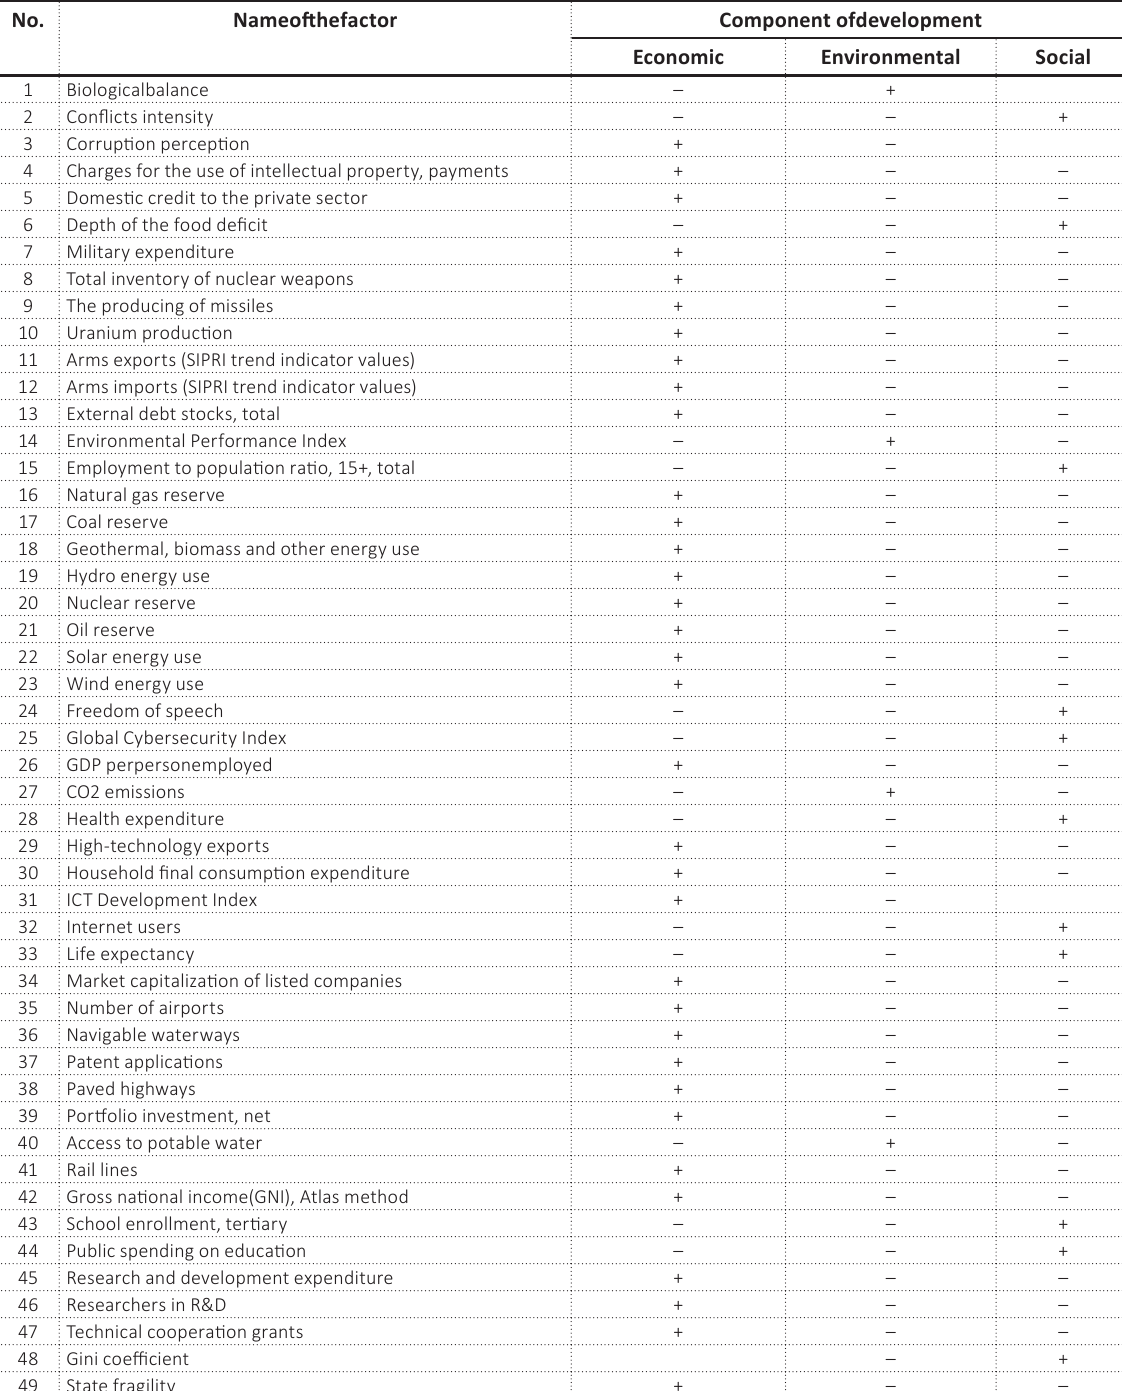
Table 4. Main factors affecting the indicators of the countries’ development Source: World Bank, World Data Center for Geoinformatics and Sustainable